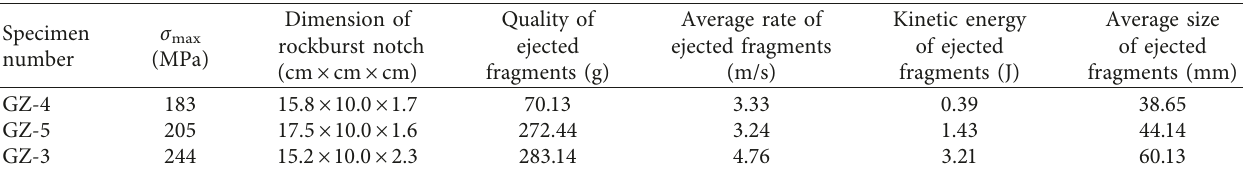
Table 5: Testing results of one-single face true-triaxial unloading test under the true-triaxial condition with different support failure timings. Specimen